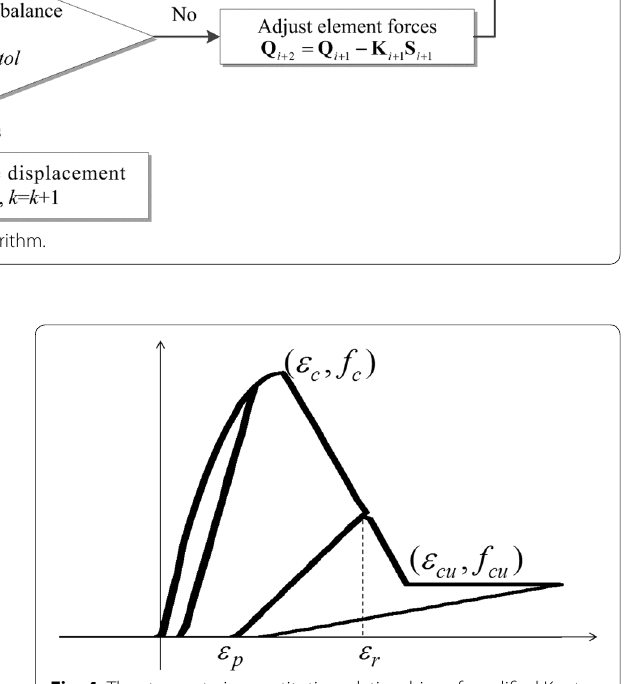
Fig. 4 The stress–strain constitutive relationships of modified Kent– Park concrete